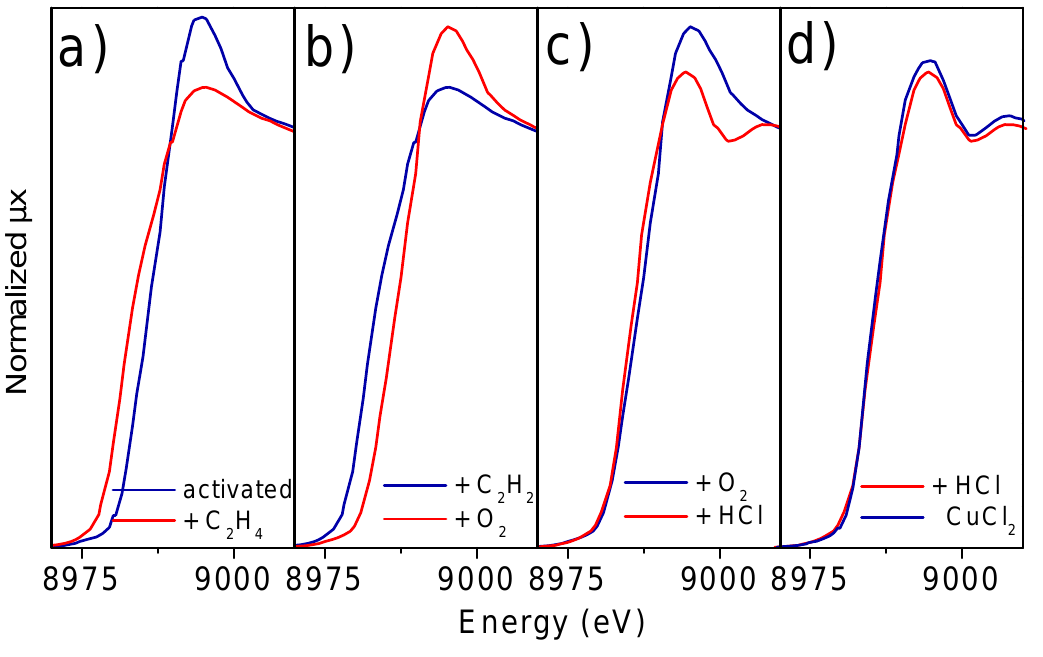
Figure 7 . Parts a-c): Evolution of the XANES spectra of the Cu7.5 catalyst, along the catalytic path